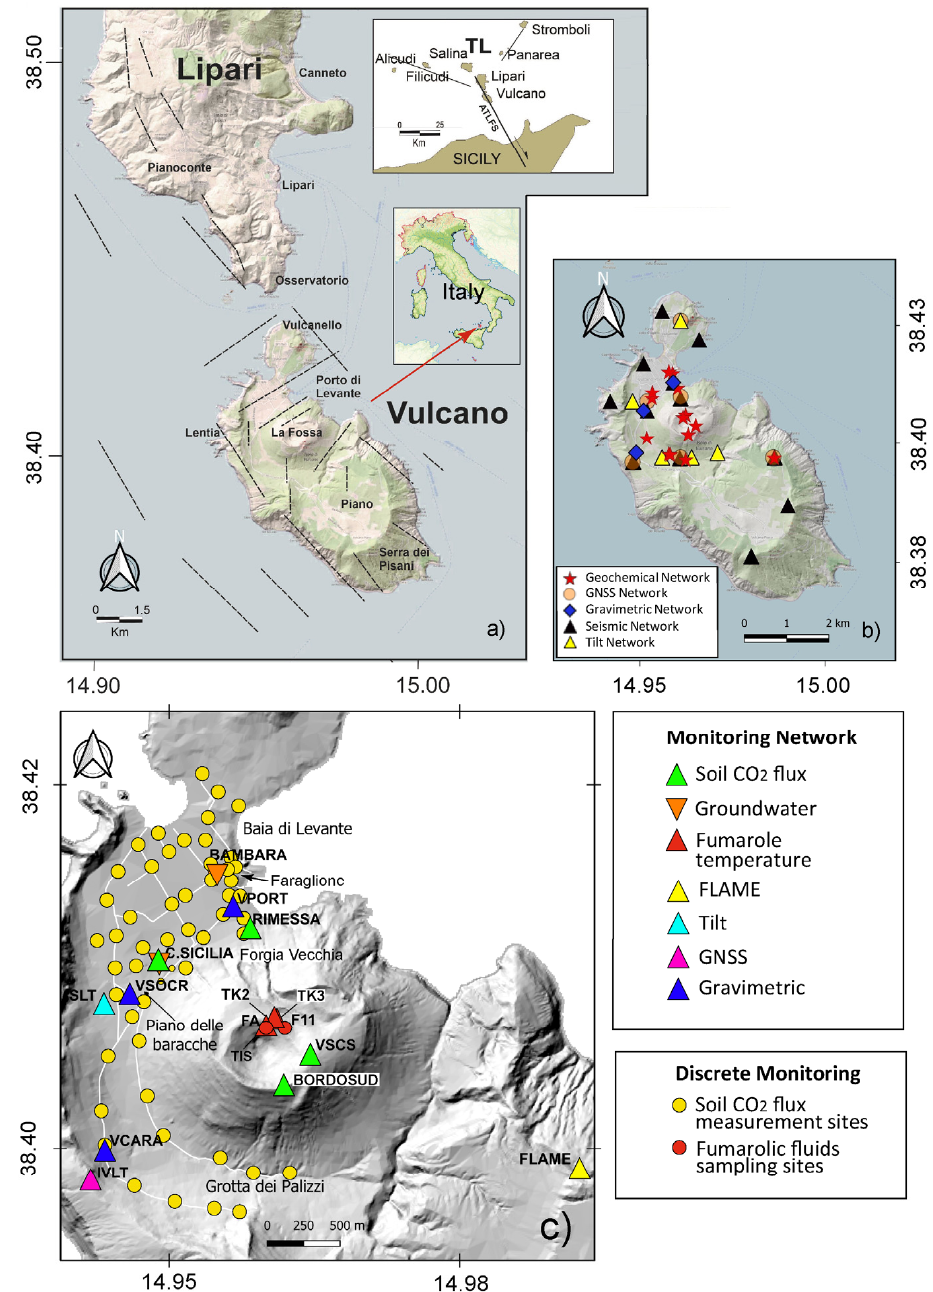
Figure 1. ( a ) Structural map of the Lipari–Vulcano area redrawn from [7,9,12,13]. The inset reports the ATLFS structure crossing the Aeolian Islands and Sicily. ( b ) Map of Vulcano Island showing the sites of the permanent and temporary networks operating during the study period. ( c ) Zoom of the northern part of the island showing the sites where geochemical investigations were performed through discrete campaigns and continuous monitoring.